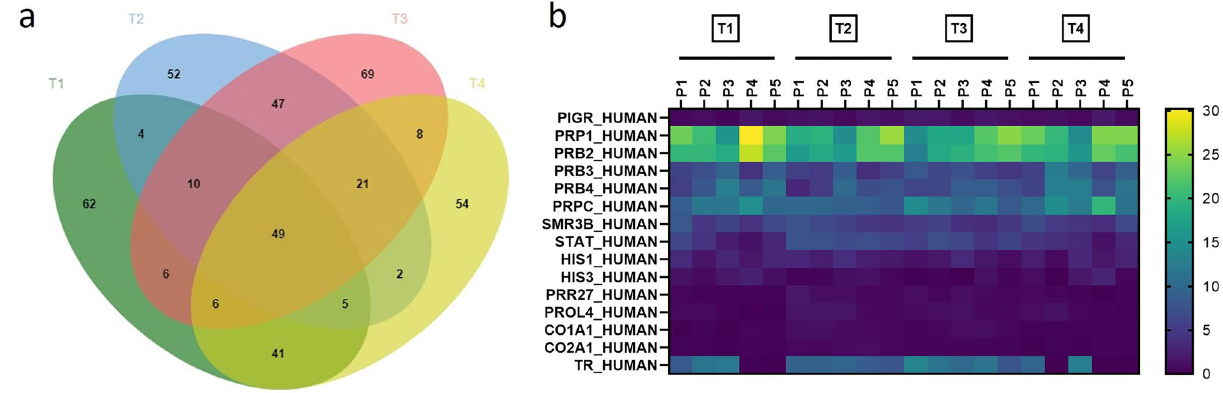
Figure 1. ( a ) Venn diagram showing the distribution of proteins of origin of the identified peptides by mass spectrometry at four time-points. T1 baseline (before placement of orthodontic appliance), T2 1 h after placement of orthodontic appliance, T3 1 week after placement of orthodontic appliance, T4 end of the alignment. ( b ) Heatmap displaying the percentages of peptides for the most abundant common proteins among all the participants (p1, p2, p3, p4, and p5) at four time-points. The scale refers to the percentages of peptides of each protein in the total number of peptides for each